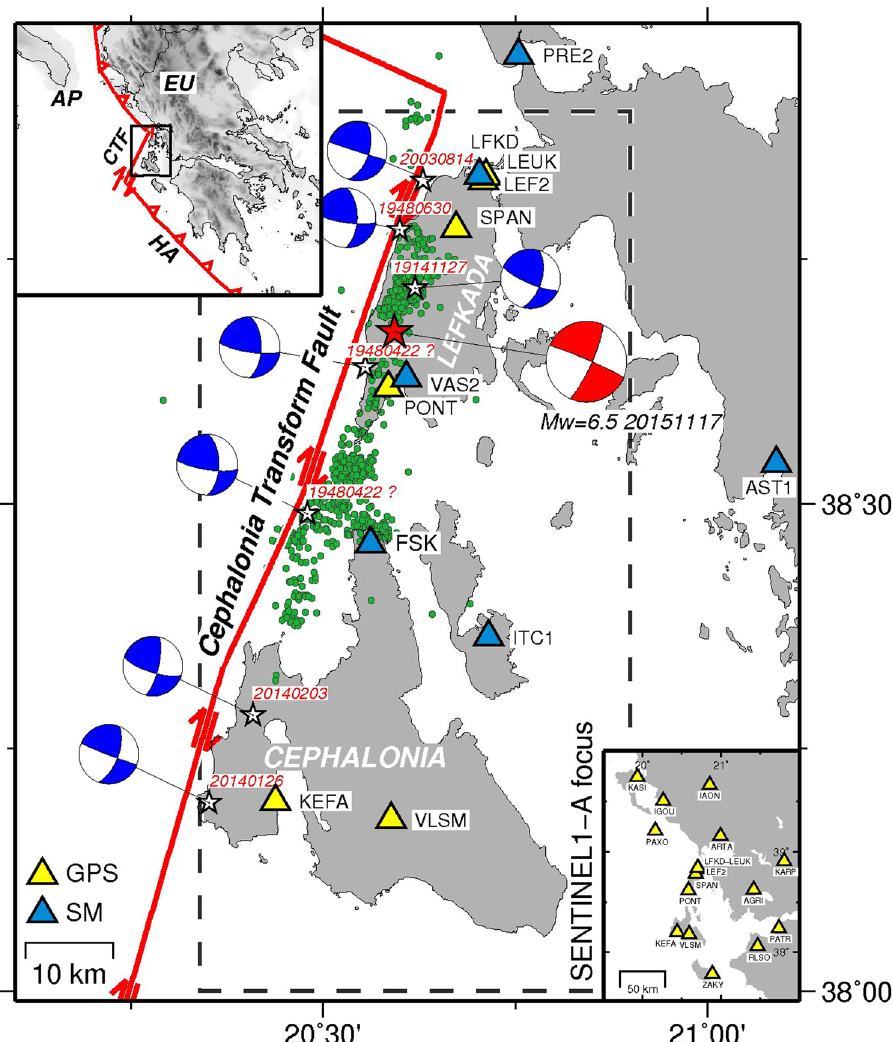
Figure 1. Seismo-tectonic settings of the investigated area. The yellow and blue triangles represent the available GPS and SM stations, respectively, used in this study. The dashed box corresponds to the Sentinel-1A swath subset selected for this study. The green dots are the 956 relocated aftershocks in time interval 2015/11/17- 2015/12/30 2 , whereas the red star and the beach ball represent the epicentre 2 and the USGS focal mechanism 3 , respectively, of the main shock. The blue beach-balls and white stars represent the estimated focal mechanisms and epicentres of the previous largest events ( M w > 6) in the investigated area 13–23 . The major structural discontinuities (red thick lines) are also shown. The inset shows the main tectonic structures: CFT, Cephalonia Transform Fault; HA, Hellenic Arc. The open rectangle indicates the investigated area. Abbreviations: Ap, Apulia; Eu, Eurasia. Map was created using the GMT (Generic Mapping Tools, http://gmt.soest.hawaii.edu/) software package 57 , version